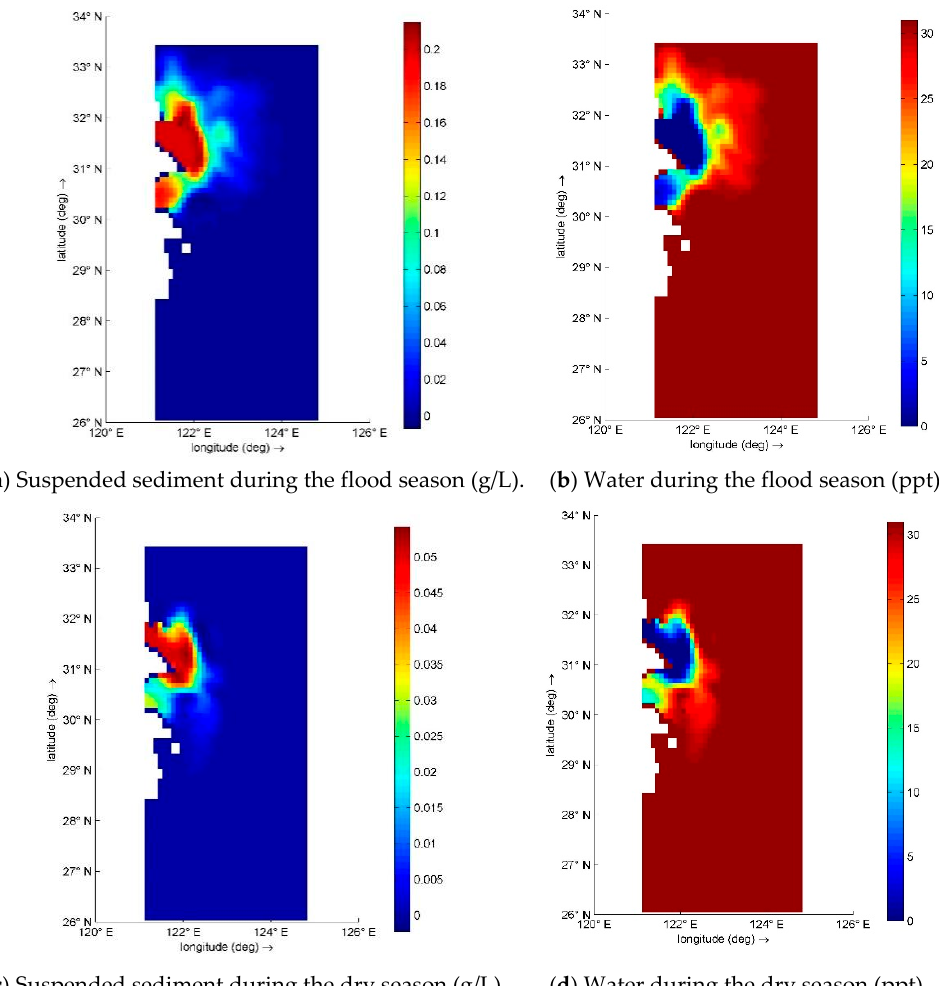
Figure 10. The diffusion of suspended sediment ( a , c ) and water ( b , d ) in the Yangtze River delta during the flood ( a , b ) and dry seasons ( c , d ) in 2018.